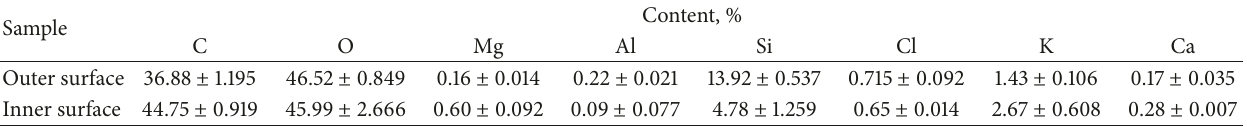
Table 1: Elemental composition in inner layer and outer layer of the rice straw.